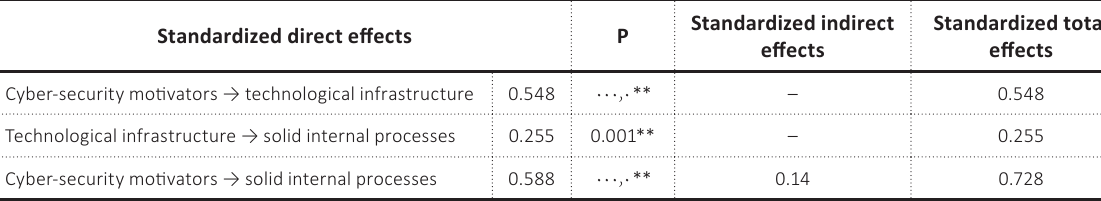
Table 9. Estimates for direct and indirect